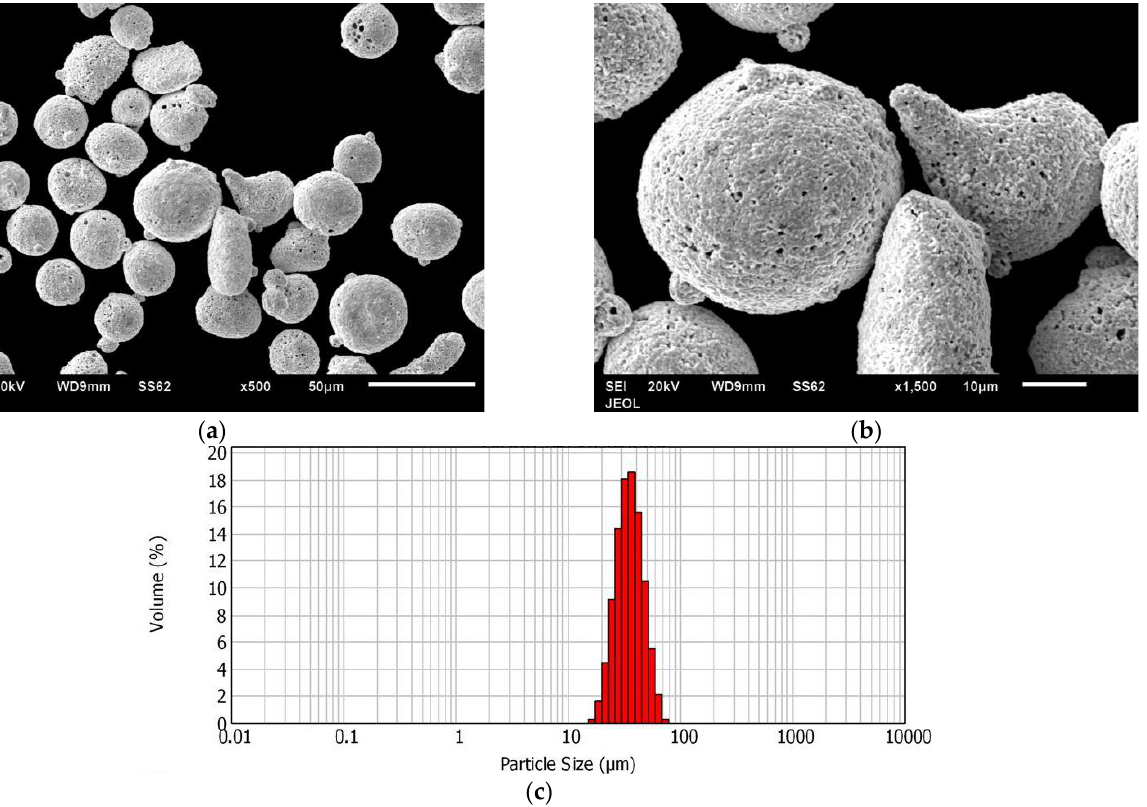
Figure 4. SEM Images of WC-10Co-4Cr powder at two magnifications: ( a ) ×500, ( b ) ×1500 and ( c ) particle size distribution.